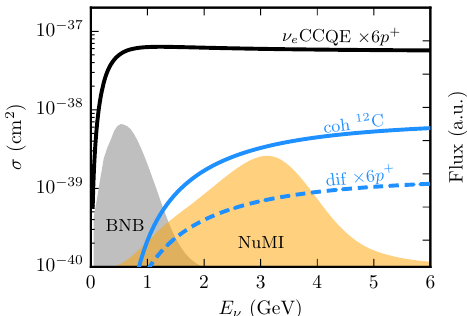
Figure 9.2: Cross section of dark neutrinos at benchmark point. The benchmark point is the same as in [ 200 ] . The blue lines correspond to the dark neutrino pro- duction cross section: solid blue for the coherent contribution and dashed blue for the diffractive contribution. For reference the ν charged-current quasielastic cross e section is shown as a solid black